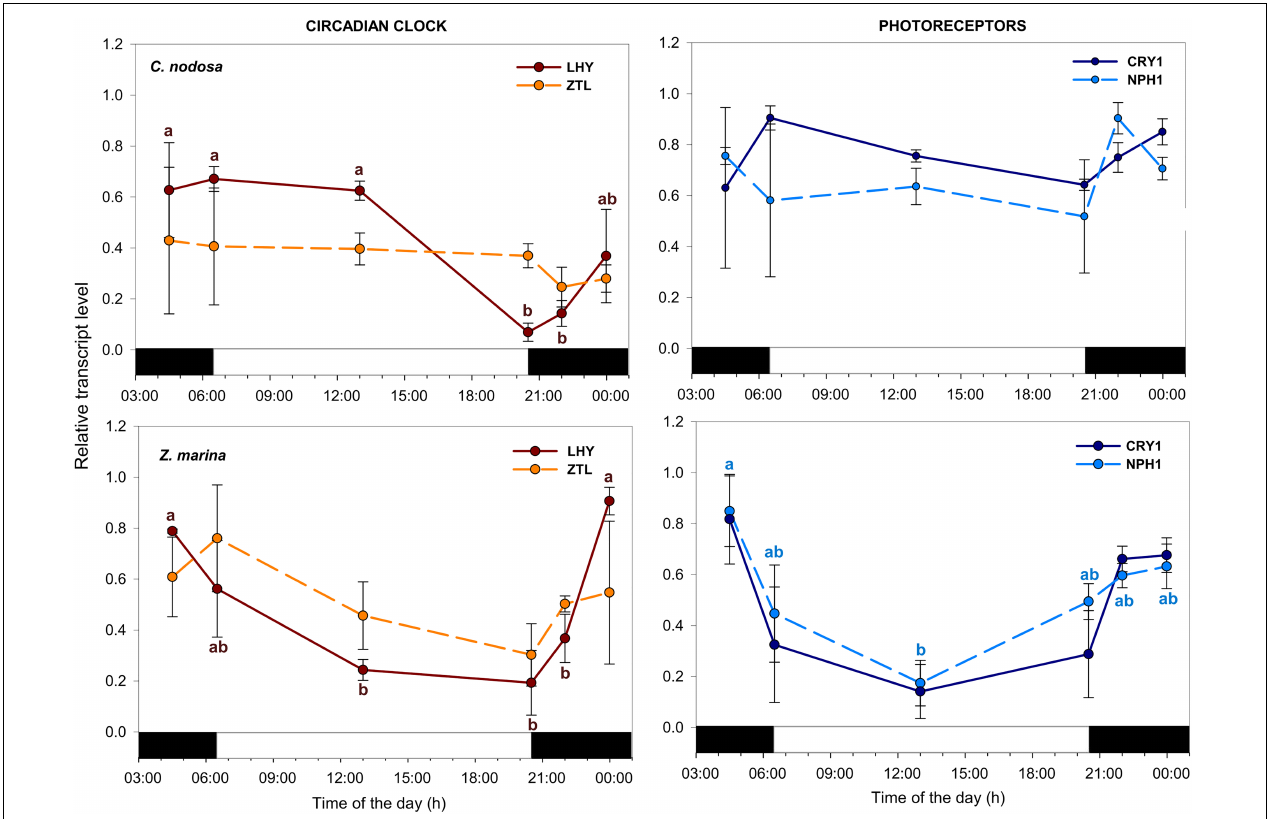
FIGURE 4 | Daily transcript levels (as normalized – (cid:49) CT data) of GOIs with a function in circadian clock and photoreception in C. nodosa (upper panels) and Z. marina (lower panels). Significant daily changes ( P < 0.05) for each GOI based on SNK tests following one-way ANOVAs ( Tables 3 , 4 ), are indicated with different letters. Letters are coloured as the respective GOI. Values are mean ± SE for n = 3.